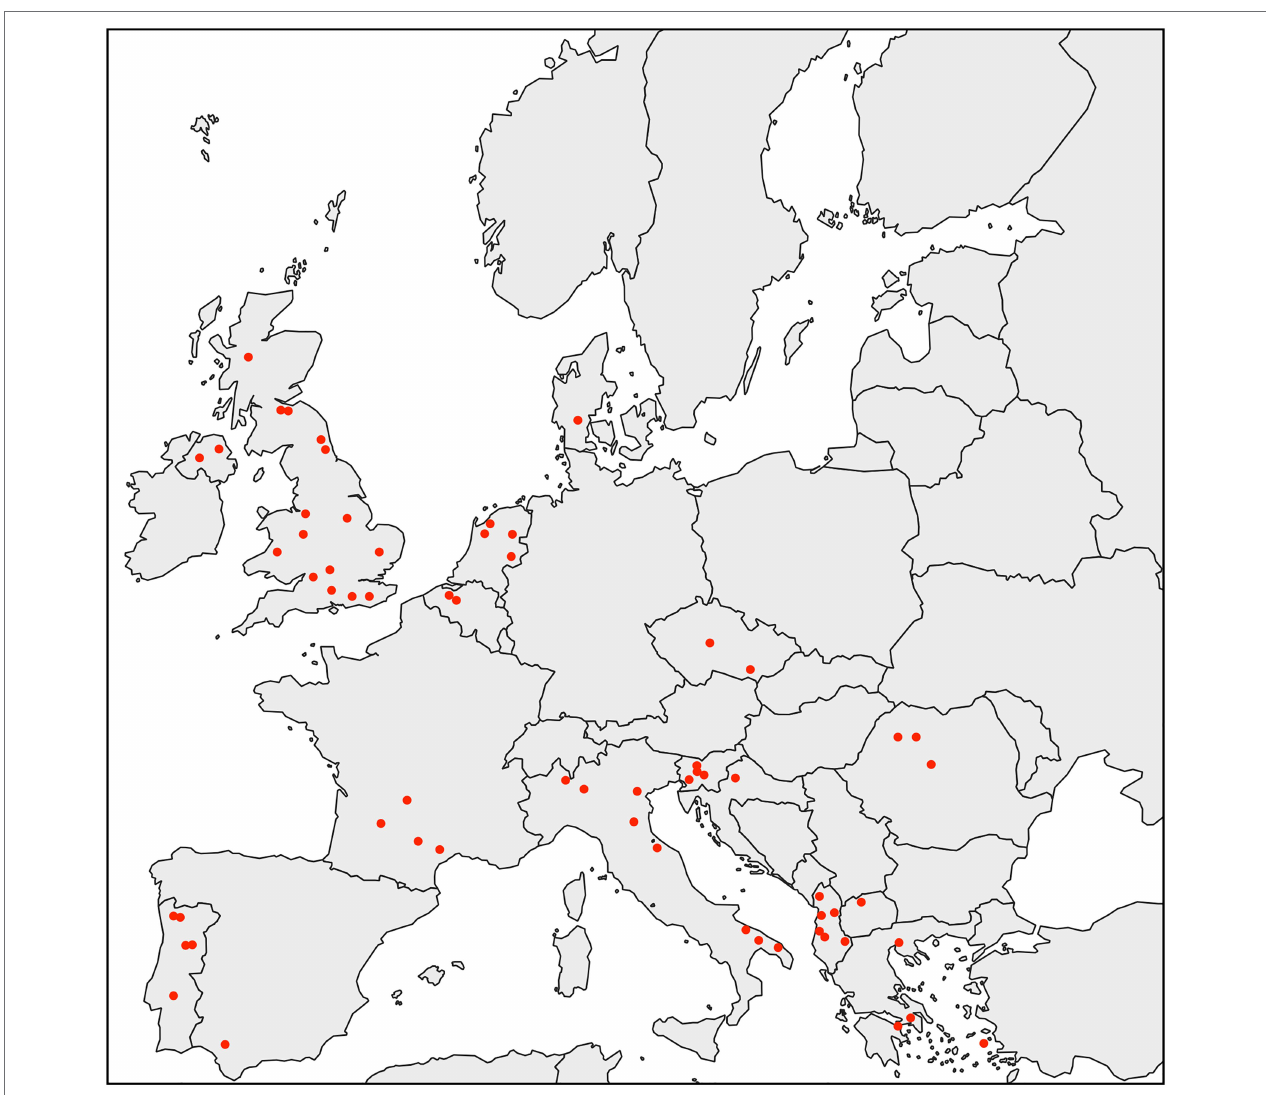
FIGURE 2 | Map showing the distribution of D. gallinae populations analyzed in this study. All individual adult female D. gallinae mites from each sampling site (63 sites across Europe) were positive for Rickettsiella infection (red circle) suggesting that Rickettsiella infection may have reached fixation in European D. gallinae